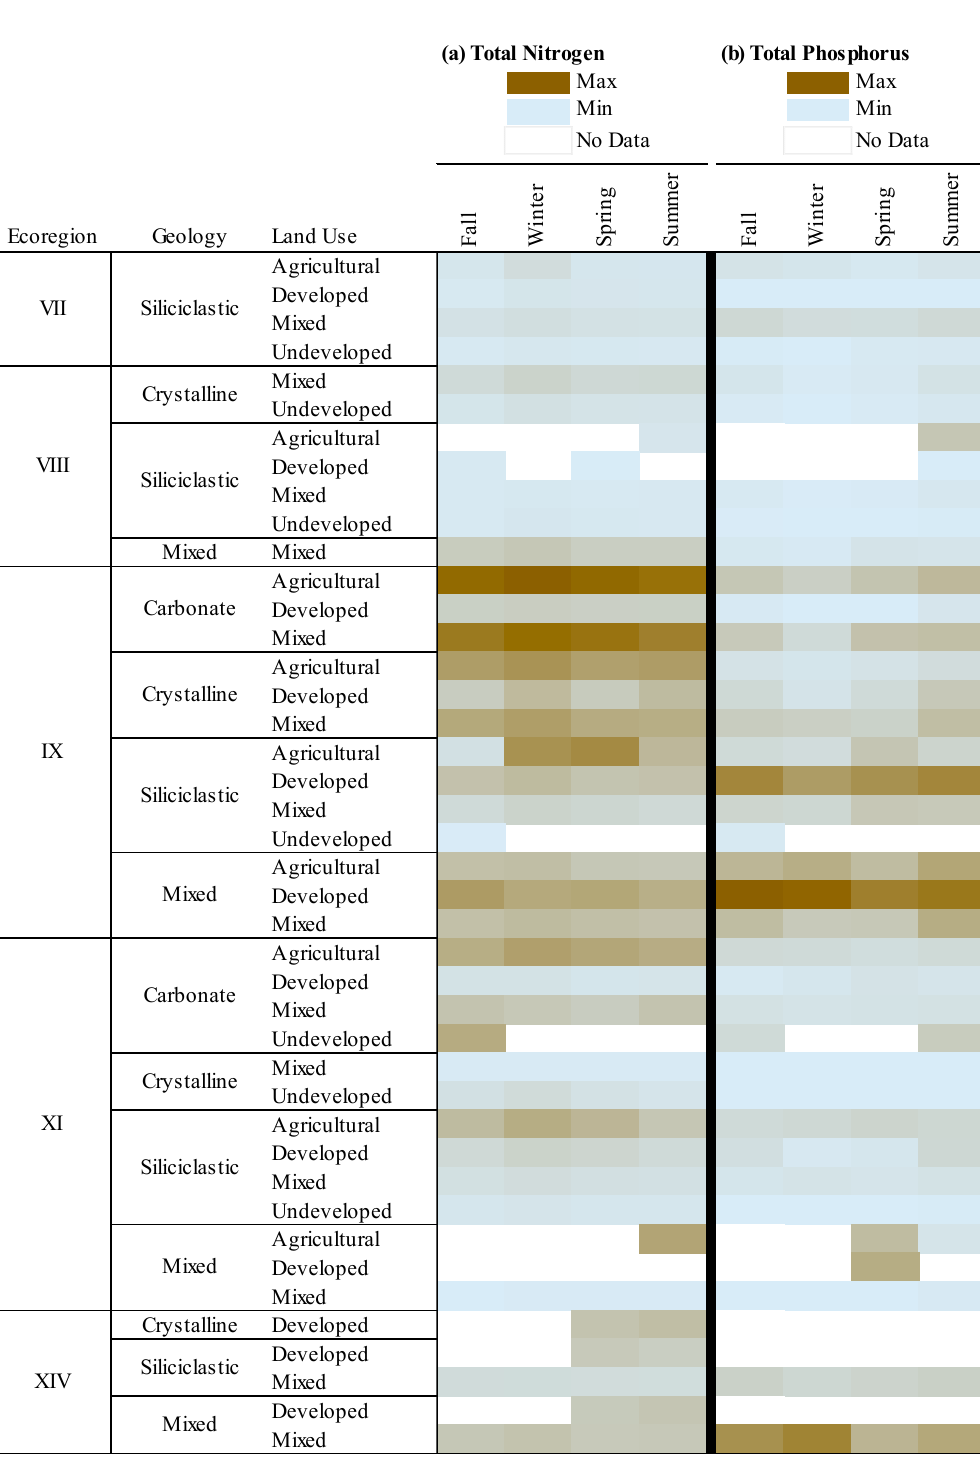
Figure 5. Seasonal variations in median nutrient concentrations of ( a ) total nitrogen and ( b ) total phosphorus among land use and geological settings within the ecoregions of Pennsylvania.